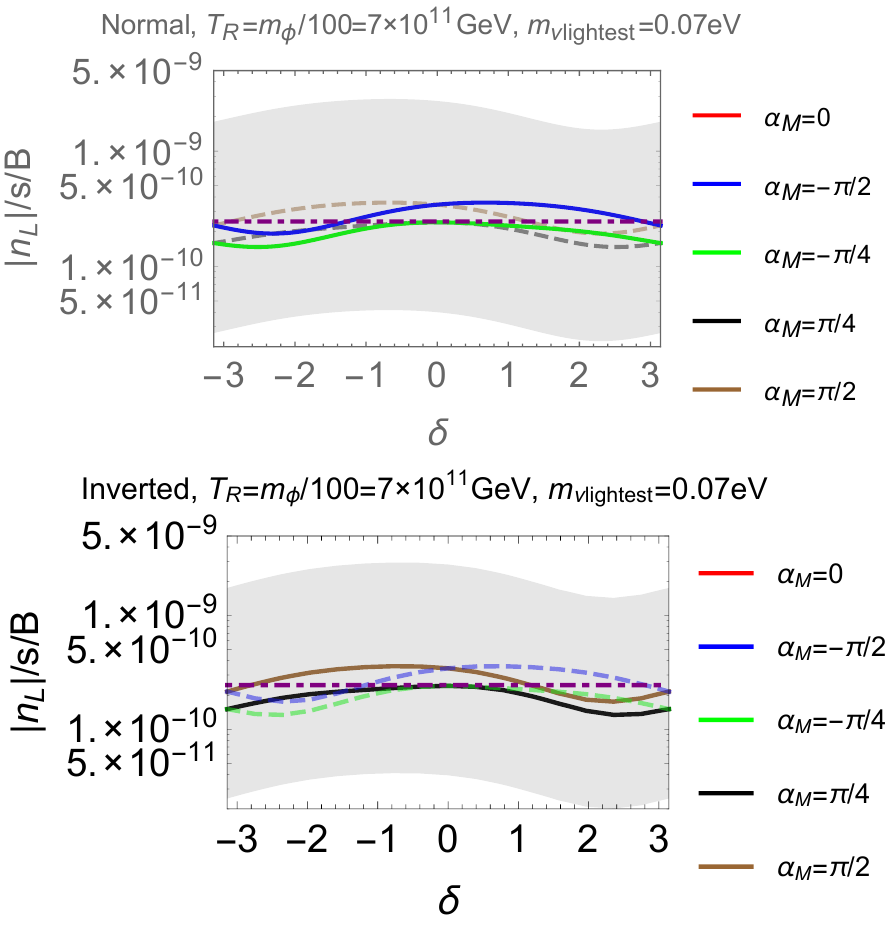
Figure 6 . Same as (cid:12)gure 5, but m (cid:23) lightest = 0 : 07 eV is taken with (cid:11) M 2 = 0. The uncertainty for (cid:11) M = (cid:25)= 2 case is shown in the gray